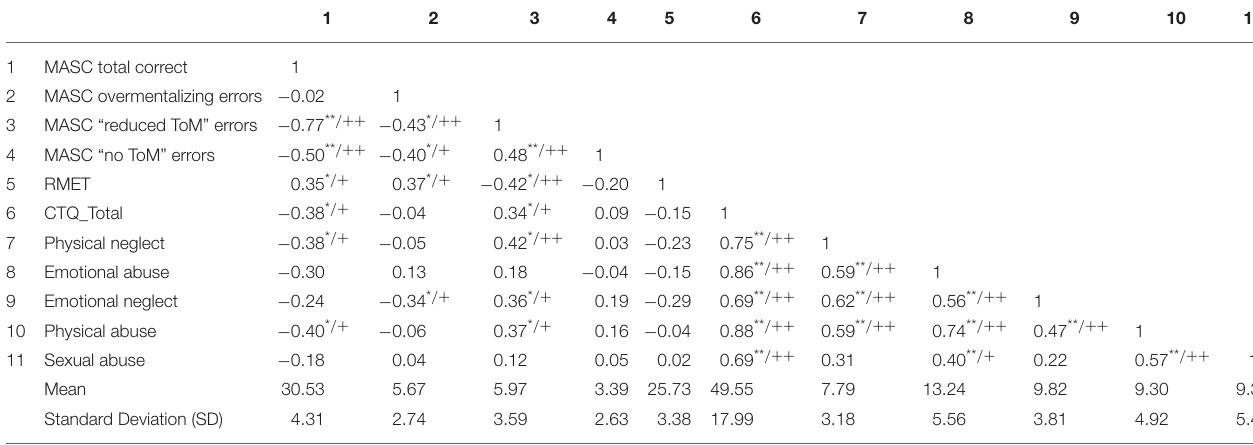
TABLE 2 | Table of correlations between variables of social cognition and CTQ scores. 1